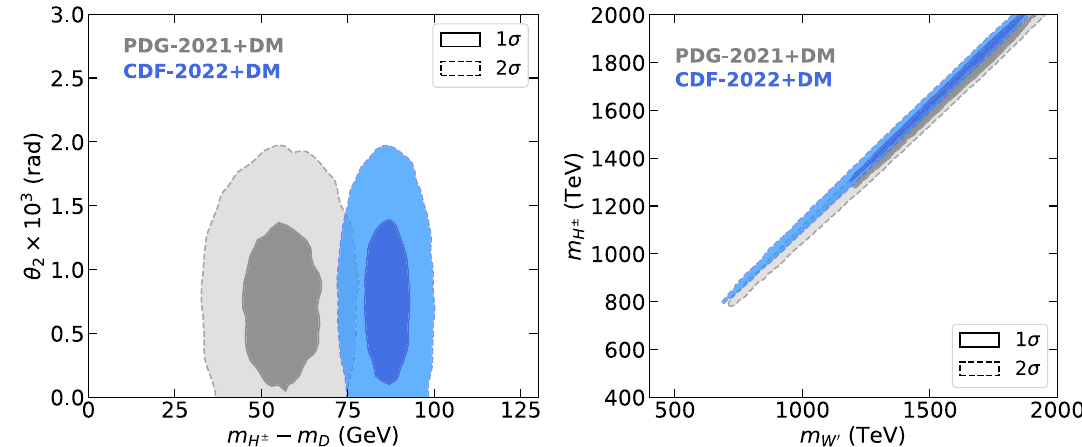
Fig. 9 The 1 σ (dark) and 2 σ (light) favored regions of the data from CDF-2021+DM (blue) and PDG-2022+DM (gray) projected on the planes of ((cid:5) m ≡ m H ± − m D ,θ 2 ) (left panel) and ( m W (cid:3) , m H ± ) (right panel) for the heavy DM mass scenario